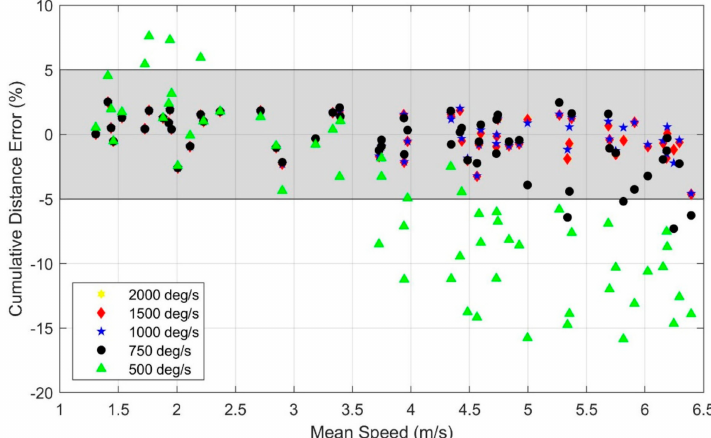
Figure 7. E ff ect of gyro range and mean running speed on the cumulative distance error. Note that distance errors arising from the 2000 and 1500 deg / s gyros are indistinguishable on this scale. The shaded region indicates estimates within ± 5%